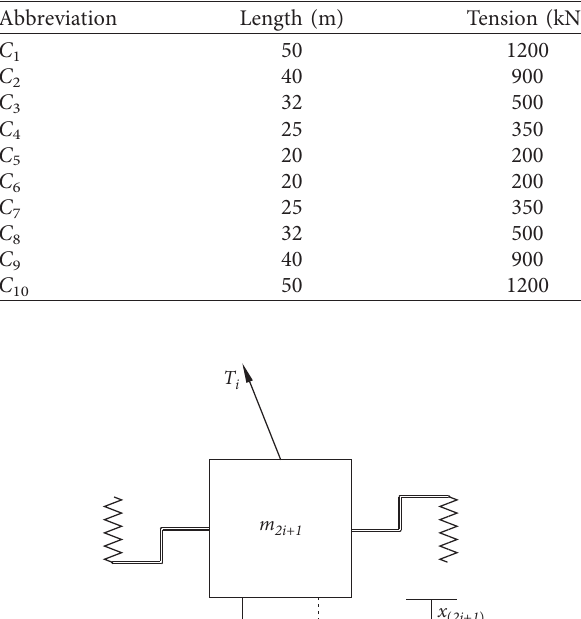
Table 3: The parameters of each subsystem cable.